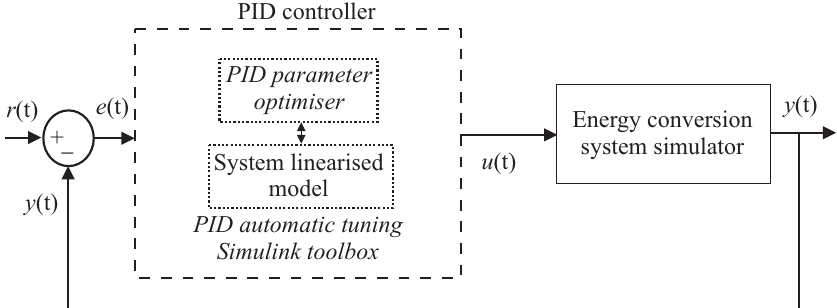
Figure 5. Block diagram of the monitored system controlled by the PID regulator with self-tuning